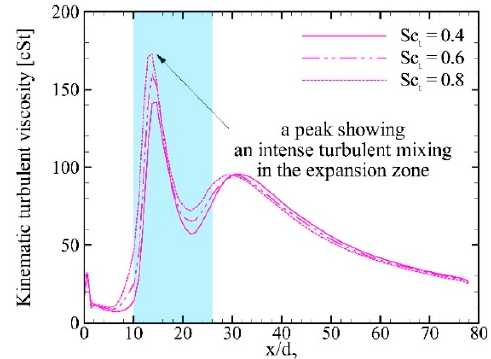
Figure 11. Time-averaged kinematic turbulent viscosity along central-axis for different turbulent Schmidt numbers.